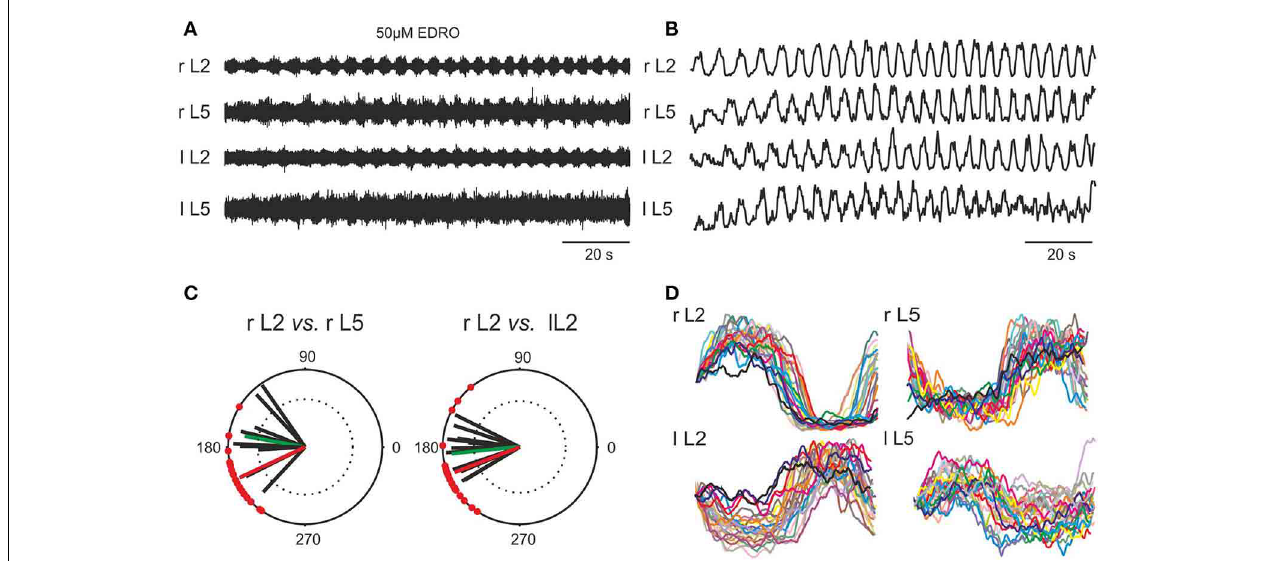
FIGURE 2 | Induction of locomotion in vitro by 50 µ M EDRO. (A) ENG recordings showing sustained alternating flexor/extensor and left/right activity. (B) Rectified and filtered waveforms of the traces in (A) . (C) Polar plots derived from pooled data from 19 experiments showing the circular distribution of mean phase values and mean angles of the right flexor ventral root ENG (r L2) vs. the right extensor ventral root ENG (r L5), and right (r L2) vs. left (l L2) flexor ENGs (green vectors). The superimposed r vectors show the concentration of phase values around